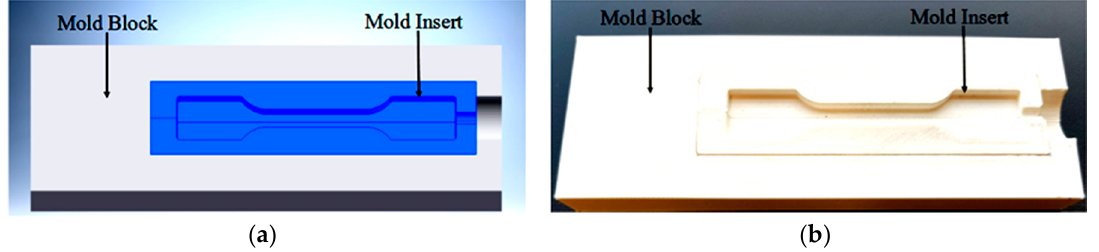
Figure 1. ( a ) CAD model of mold assembly and ( b ) FDM printed mold assembly.